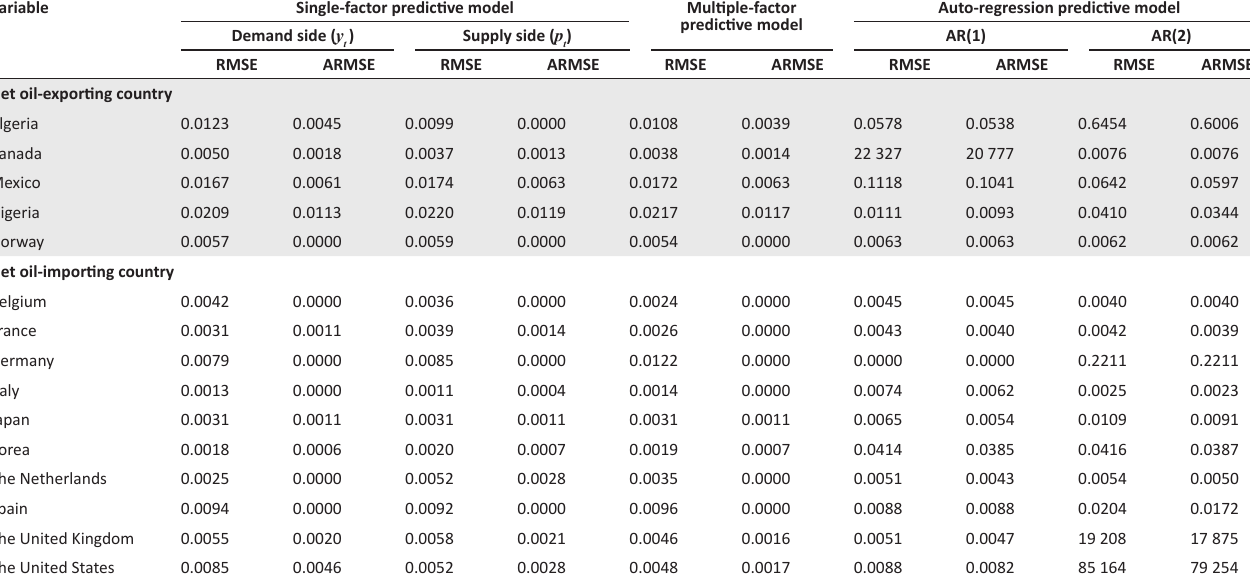
TABLE 8: Out-of-Sample Forecast Performance using the root mean square error and adjusted root mean square error for k = 1 (75 % sample size). Variable